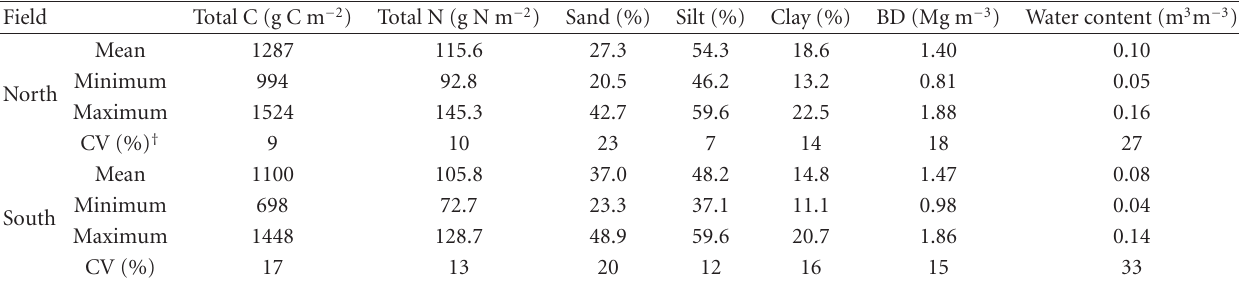
Table 1: Statistical summary of the surface horizon (0–0.15 m) characteristics in August